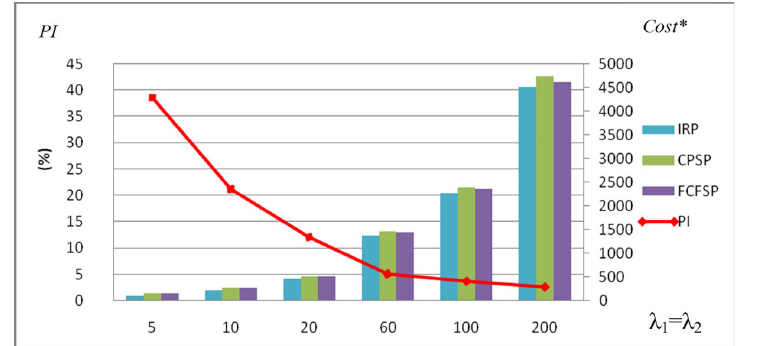
Fig 7. The performance of the inventory rationing policy.